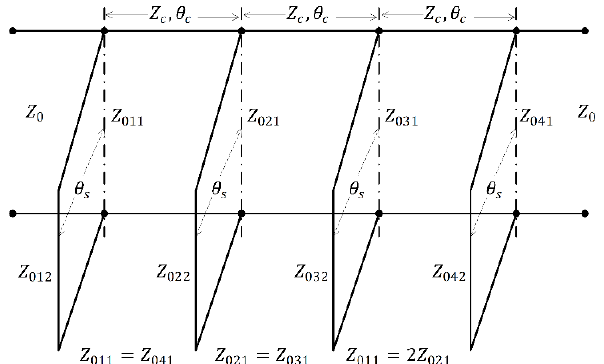
Figure 5. Modified UWB bandpass filter structure with TTL short-circuited stubs of length θ s and tapered impedance Z 012 = Z 042 and Z 032 = Z 022 .